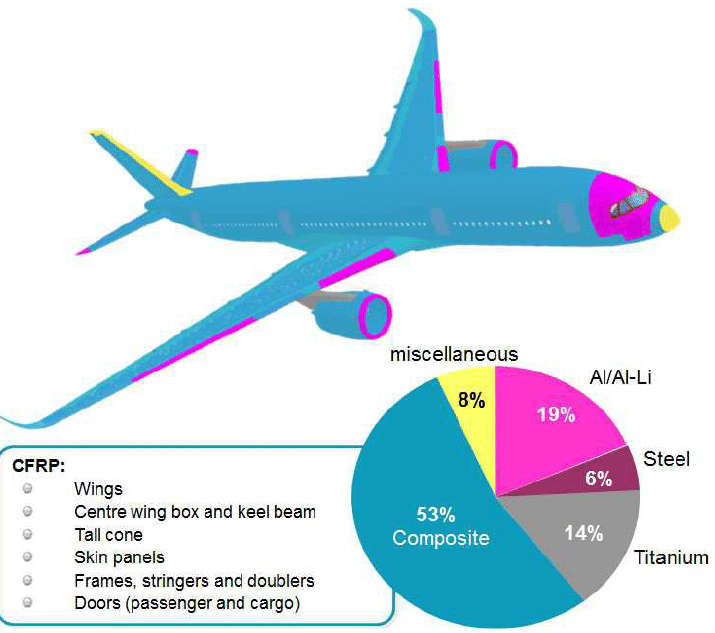
Figure 11. Materials used in the Airbus 350 XWB (reprinted with permission from Ref. [48]).